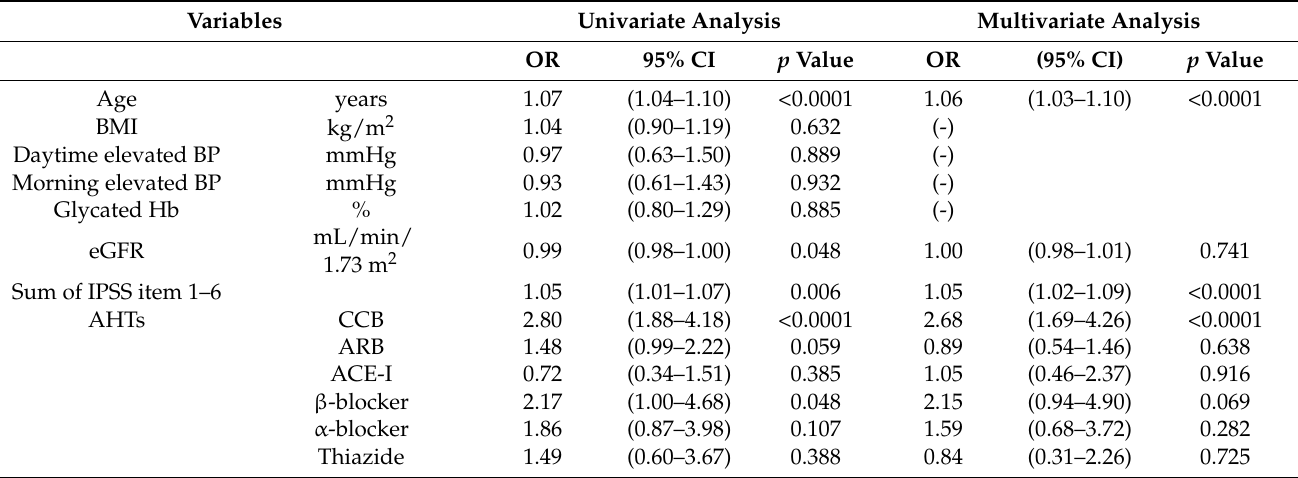
Table 3. Univariate and multivariate analysis to analyze factors associated with clinically important nocturia. Variables Univariate Analysis Multivariate Analysis